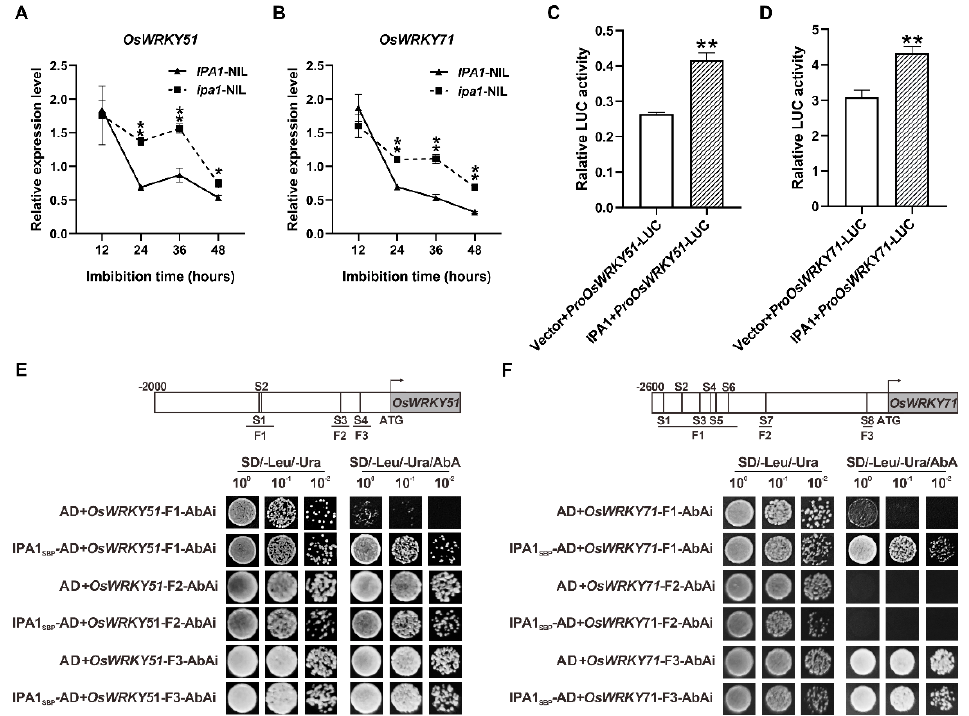
Figure 5. IPA1 positively regulates the expression of OsWRKY51 and OsWRKY71 . ( A , B ) The relative expression level of OsWRKY51 ( A ) and OsWRKY71 ( B ) at different time points. Values are means ± SE ( n = 3). ( C , D ) Relative LUC activities of ProOsWRKY51 ( C ) and ProOsWRKY71 ( D ) reporter after co-expression with IPA1 in rice protoplasts, respectively. The pRGV vector was used as control. Relative LUC activity was calculated by LUC/Ren. Values are means ± SD ( n = 3). Significant differences were determined using Student’s t -test (* p < 0.05, ** p < 0.01). ( E , F ) Y1H assays to dissect the binding regions of IPA1 in the promoter regions of OsWRKY51 ( E ) and OsWRKY71 ( F ), respectively. The core GTAC motifs are marked as S1, S2, and so on.